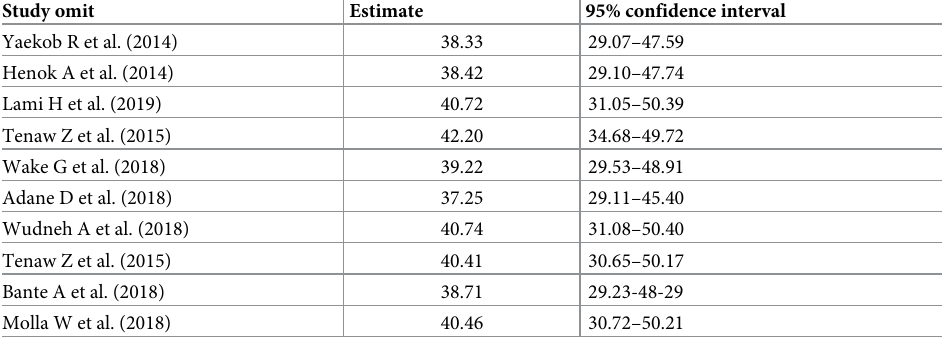
Table 2. Sensitivity analysis of the pooled prevalence of practices of active management of the third stage of